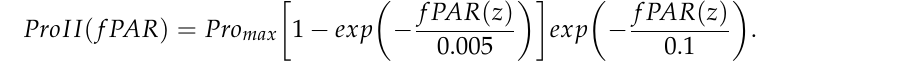
Table 2. Parameters and coefficients used in Equations (1) to (8) with their standard deviations ( σ ).